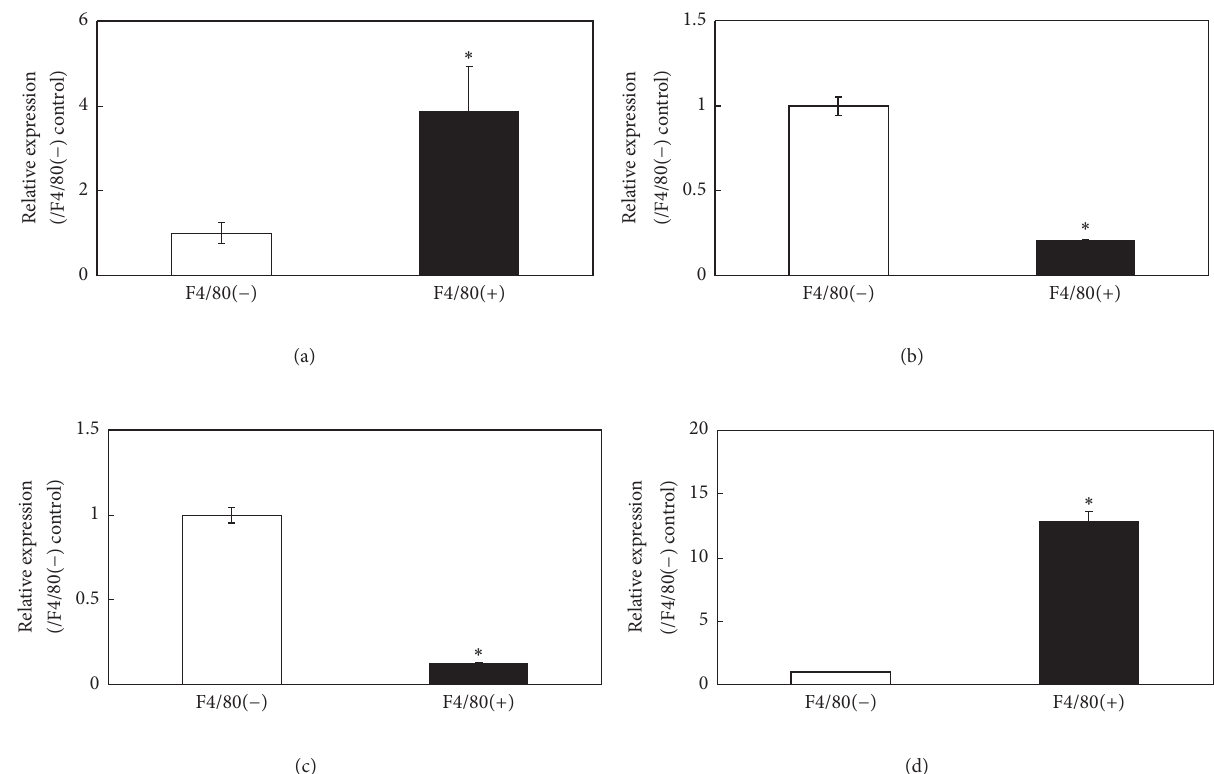
Figure 3: Real-time polymerase chain reaction (PCR) analysis for interleukin- (IL-) 1 𝛽 , adrenomedullin (AM), receptor activity-modifying protein 2 (RAMP2), and RAMP3 gene expression in F4/80-negative and -positive cells derived from inflamed synovial tissue. (a) IL-1 𝛽 , (b) adrenomedullin (AM) , (c) receptor activity-modifying protein 2 (RAMP2) , and (d) RAMP3 gene expression in ST obtained from the control and dislocated side of a patellar surgical dislocation model generated in C57BL/6J mice. ∗ Statistically significant difference between F4/80- negative and F4/80-positive fractions. All data are presented as the mean ± standard error ( 𝑛 = 5